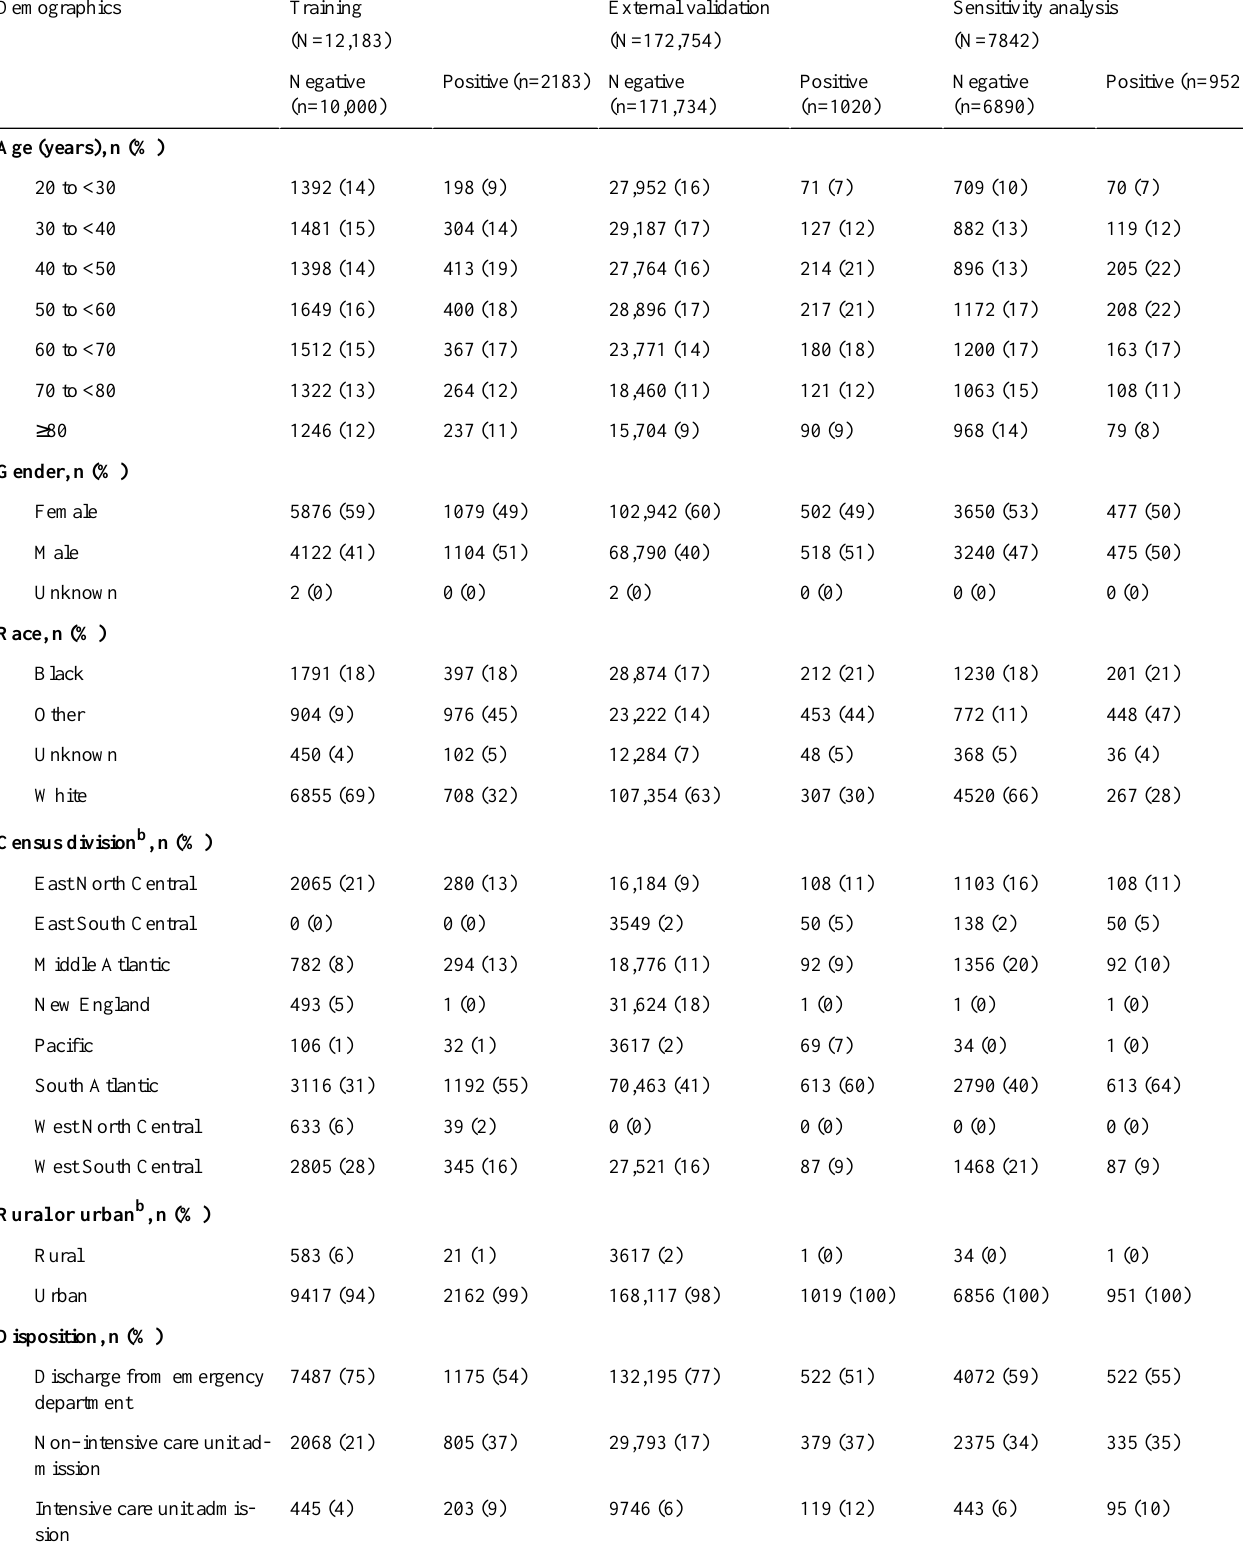
Table 1. Demographics of patients and encounter details, by COVID-19 status a